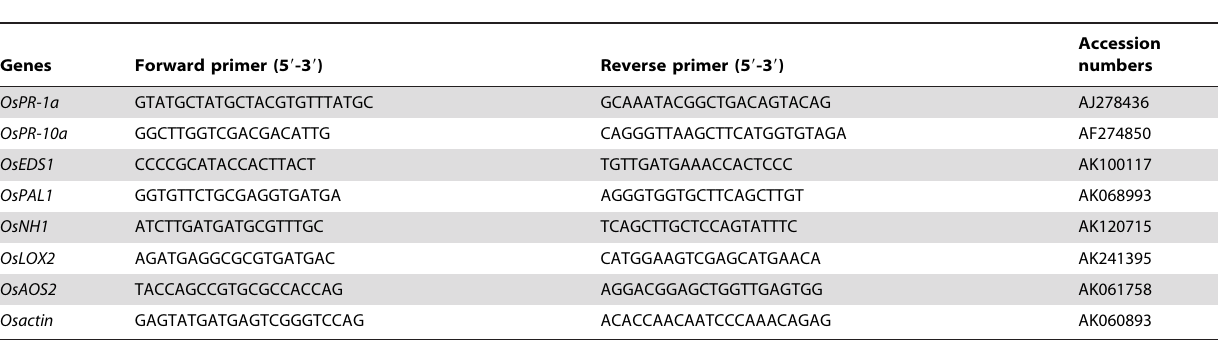
Table 2. Primers used for real-time RT-PCR of pathogenesis-related and actin genes.